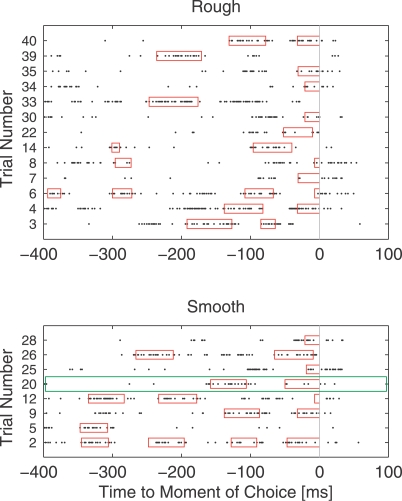
Activity of the Same Neuronal Cluster in the Course of a SessionTrial 20, depicted in Figure 2, is highlighted by a green box. Spike times are relative to moment of choice (gray line). Contacts of whisker C2 occurring before choice are marked by red frames. Note the increase in firing rate during contact. On missing trial numbers, whisker contact times could not be defined.